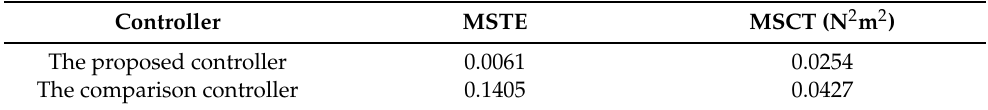
Table 2. Performance indexes for the